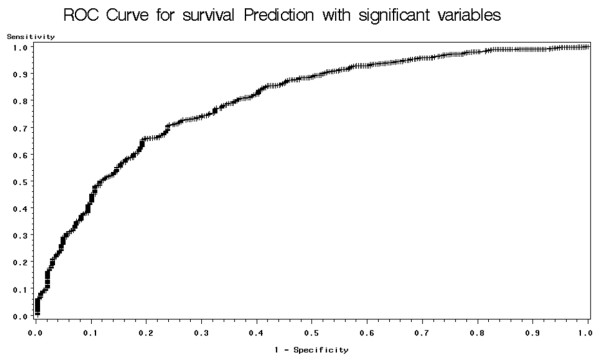
ROC plot for Logistic regression on survival prediction. This figure presents the ROC plot obtained when applying logistic regression for survival prediction, using only significant variables. Tables 8 and 9 contain AUC (area under curve) results for the other machine learning methods and the other prediction scenarios.